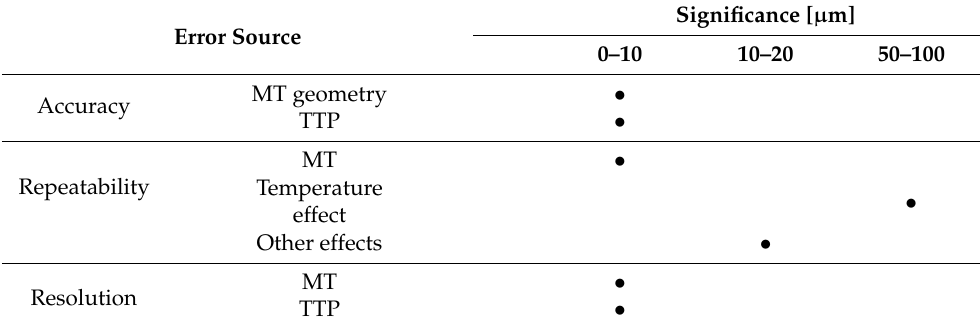
Table 15. General error budget of part probing system for medium-sized MTs